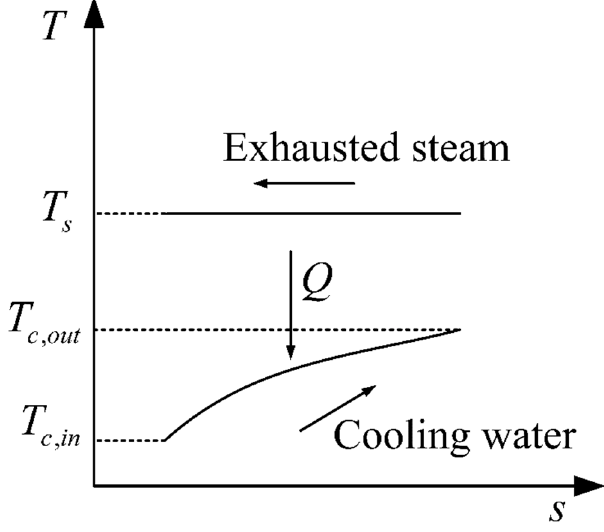
Figure 2. T-s diagram of heat exchange process in the